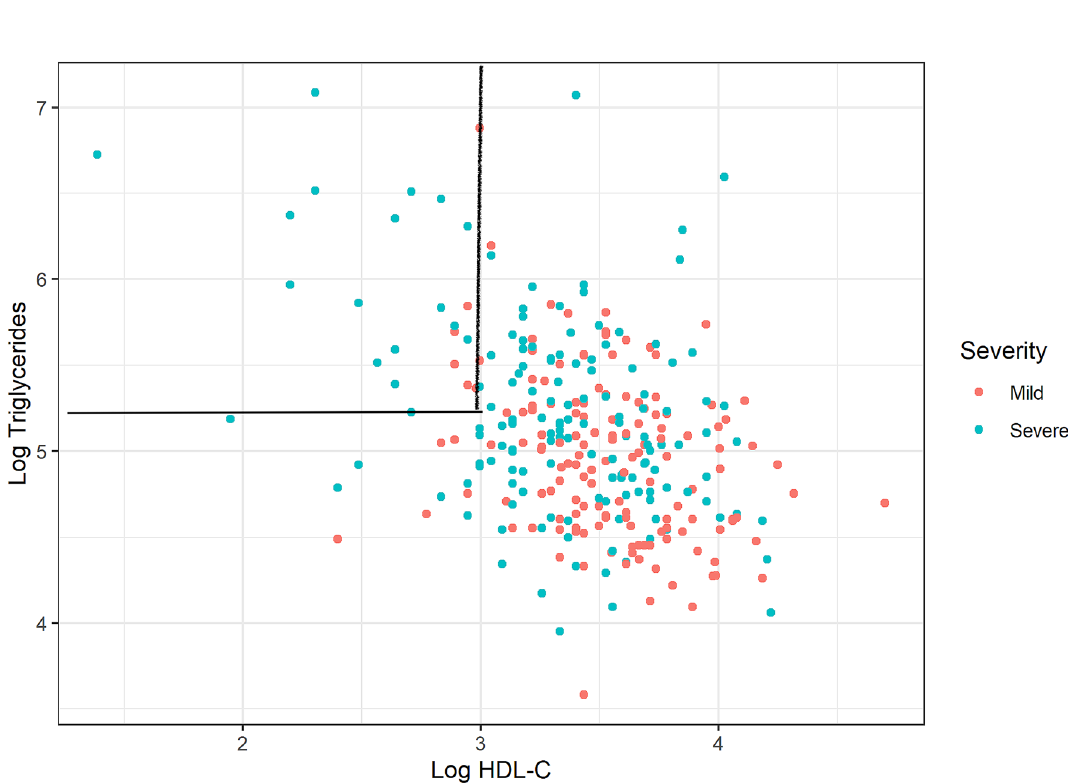
Figure 4. Distribution of patients according HDL-C and TG concentrations and COVID-19 severity. The upper left square shows that only severe patients were in the low HDL-C, high triglyceride